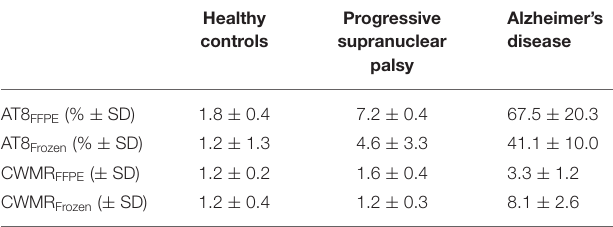
TABLE 2 | Immunohistochemistry and autoradiography results.